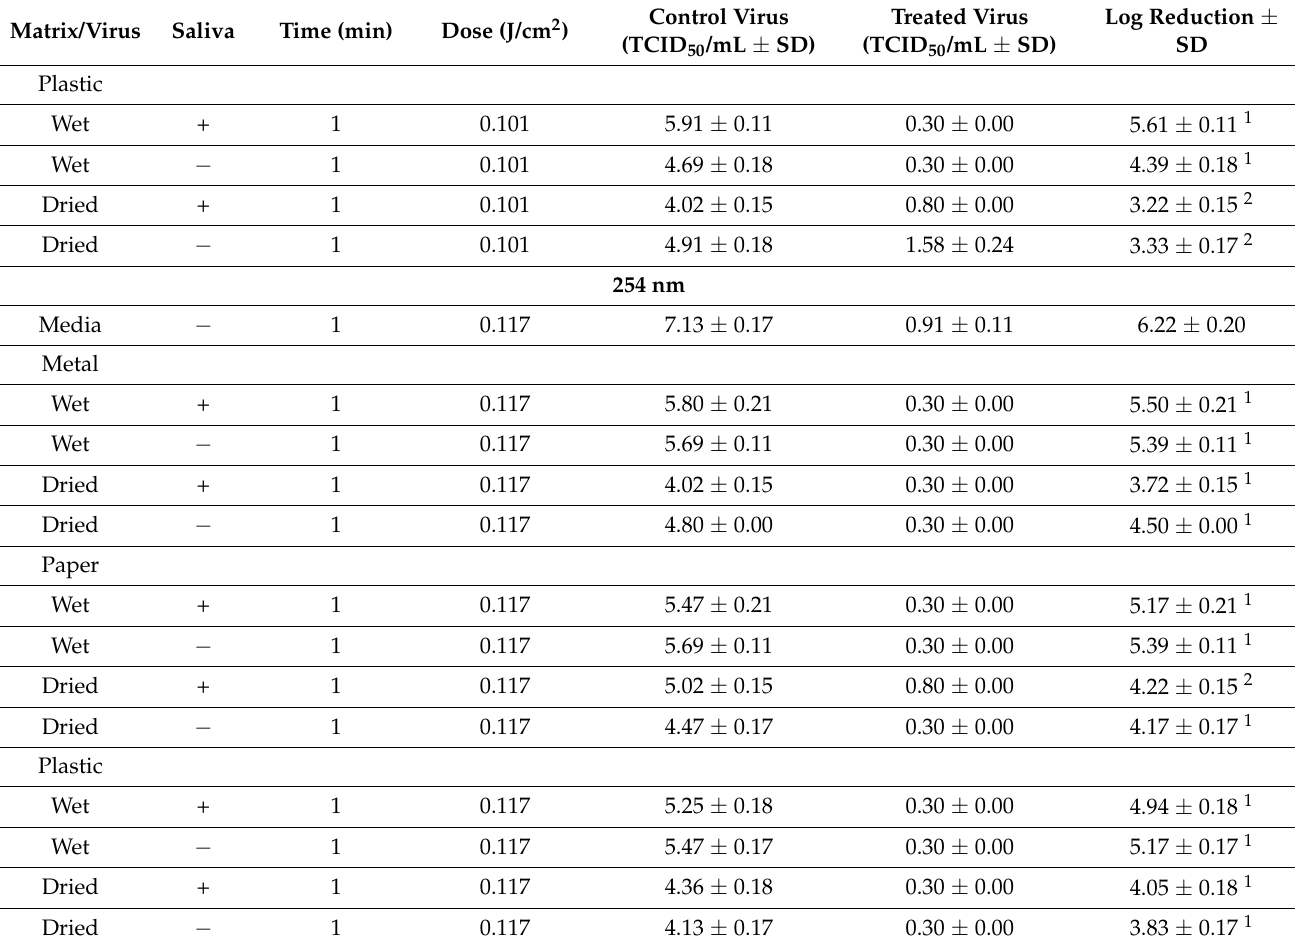
3.2. Inactivation of FIPV in Liquid Suspension after Exposure to Light at 405 nm and 222 nm Exposure of FIPV in liquid suspension to dual 405 nm + 222 nm lights resulted in a 4-log reduction in titre within 30-min of exposure (Figure 1). In comparison, FIPV exposed to individual 222 nm or 405 nm lights showed only a 1-log reduction in titre after 30-min. Although the log reduction increased with longer exposure to individual lights for both 222 nm and 405 nm, the combined effect of two lights was always stronger than the effect of each individual light, with approximately a 6-log reduction observed after a 60- and 90-min exposure (Figure 1). This level of reduction was 1 to 2 logs higher compared with exposure to 405 nm light alone, and 3 to 4 logs higher compared with exposure to 222 nm light